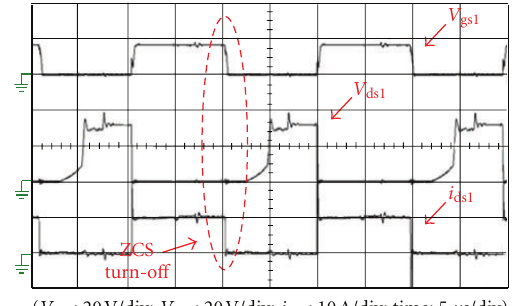
Figure 12: Measured voltage and current waveforms of the power switch M 1 .